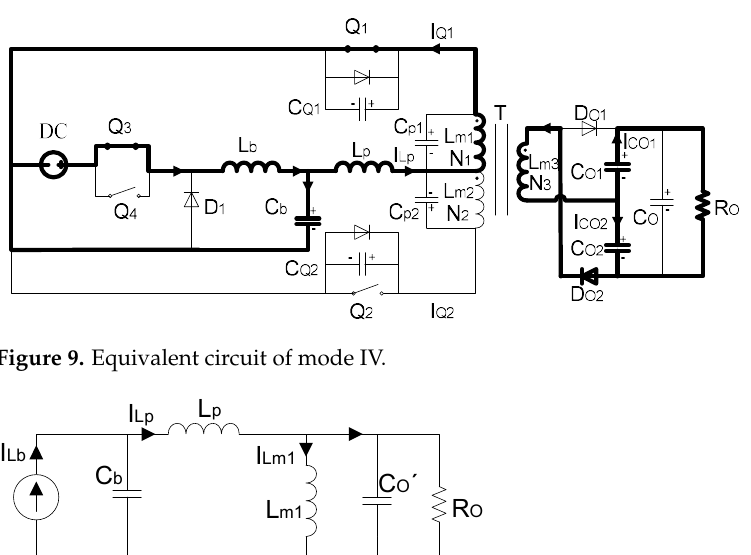
Figure 10. When the switch 𝑄 (cid:2869) turns on, this circuit is equivalent to the circuit in Figure 9.